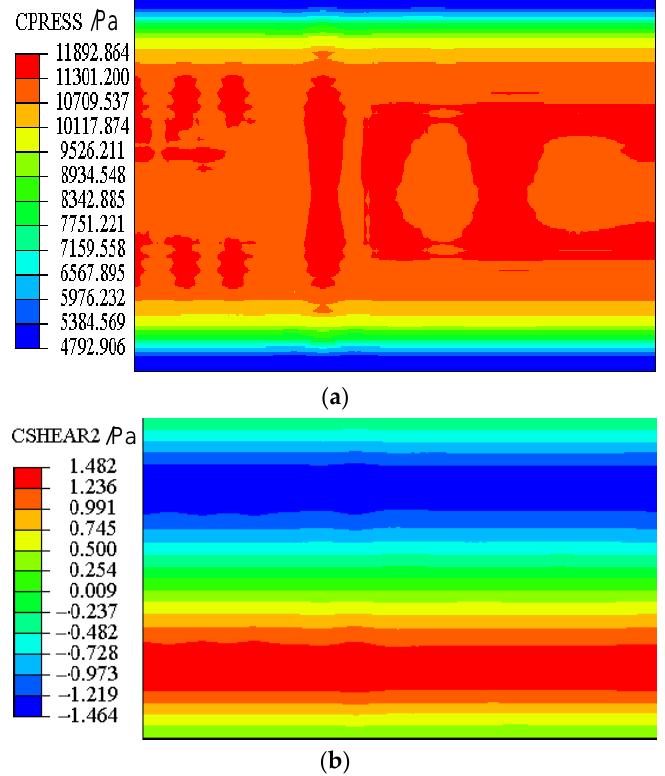
Figure 14. Stress of the sliding layer. ( a ) Normal stress. ( b ) Transverse shear stress.